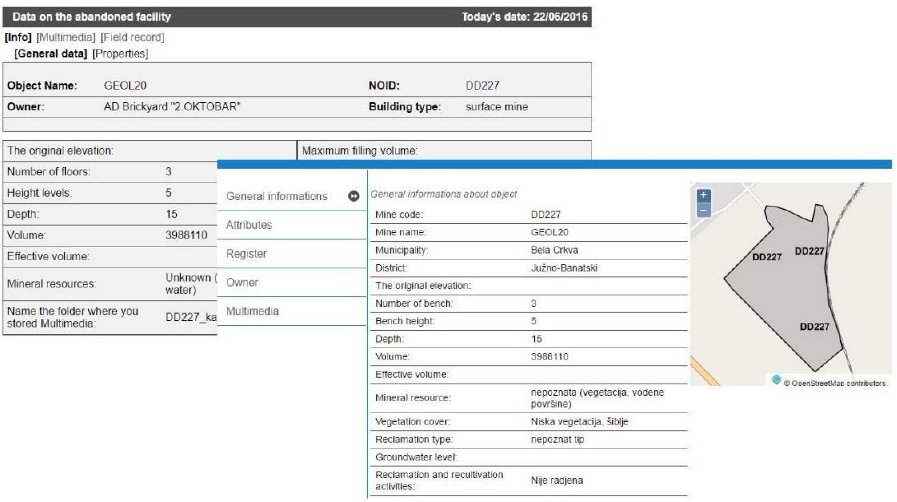
Figure 4. Panel with general data on the register of abandoned mines.